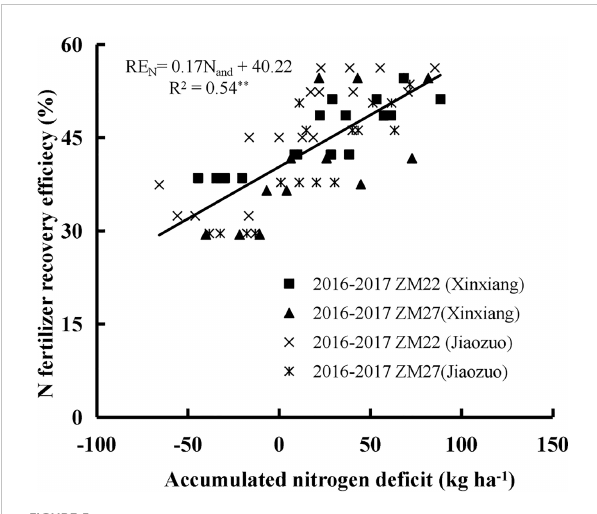
FIGURE 5 The relationship between accumulated N de fi cit and N fertilizer recovery ef fi ciency of winter wheat from 2016 to 2017 at Xinxiang and Jiaozuo. The symbol **indicates that the p -value is<0.01.